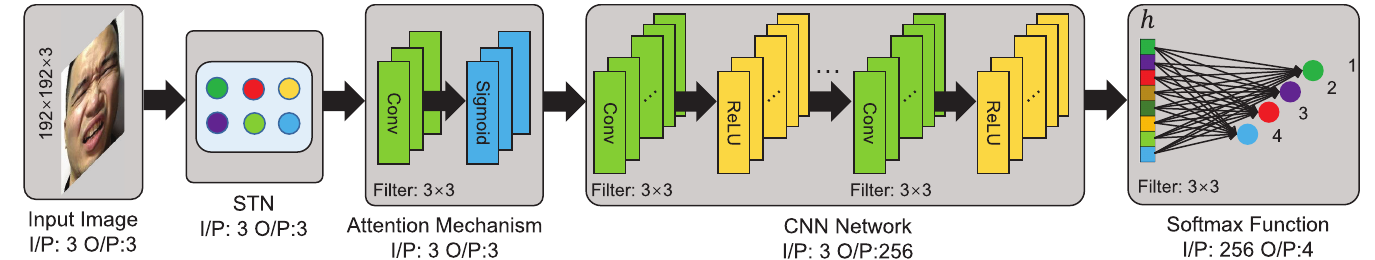
Fig 2. The architecture of the proposed pain intensity estimation method, where I/P and O/P denote the channel number of input and output feature maps, respectively. In the proposed method, the input face image is first fed into STN to against background interference; then, the attention mechanism is used to adaptively distribute different face region weights; finally, the attentional face image is input to CNN module and Softmax Function to extract features and classify pain levels.